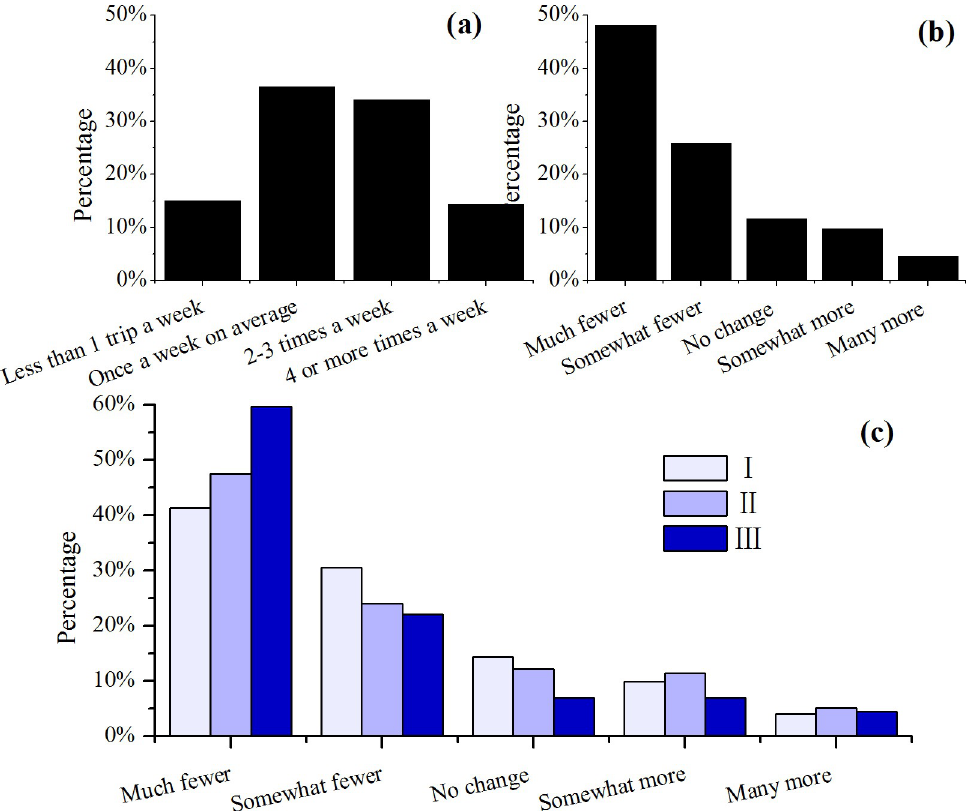
Fig 3. Frequency of grocery shopping trips before the pandemic (a), changes during the home quarantine (b), and age groups differed in cutting down grocery shopping trips (c, p < 0.001) during the COVID-19 pandemic.